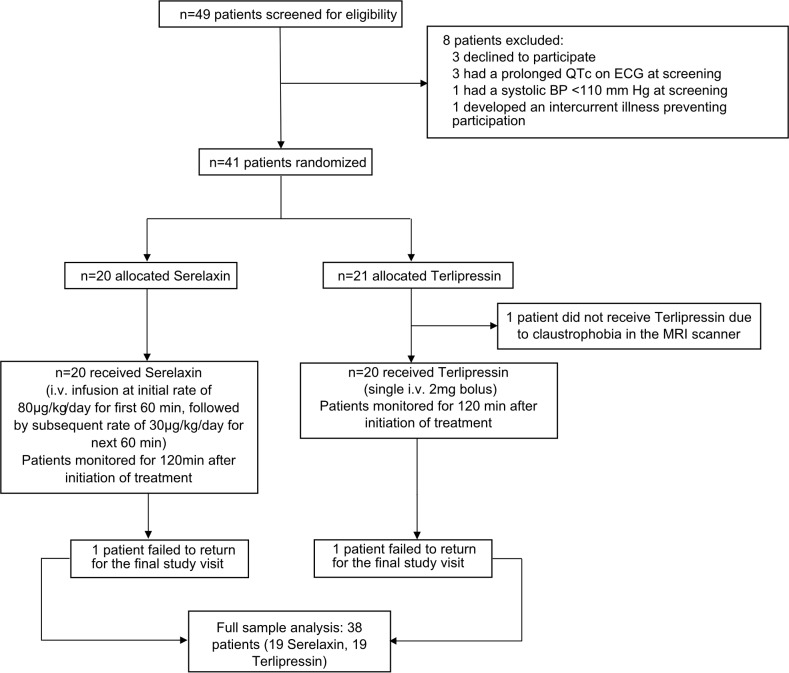
Flow chart of participants in the study.